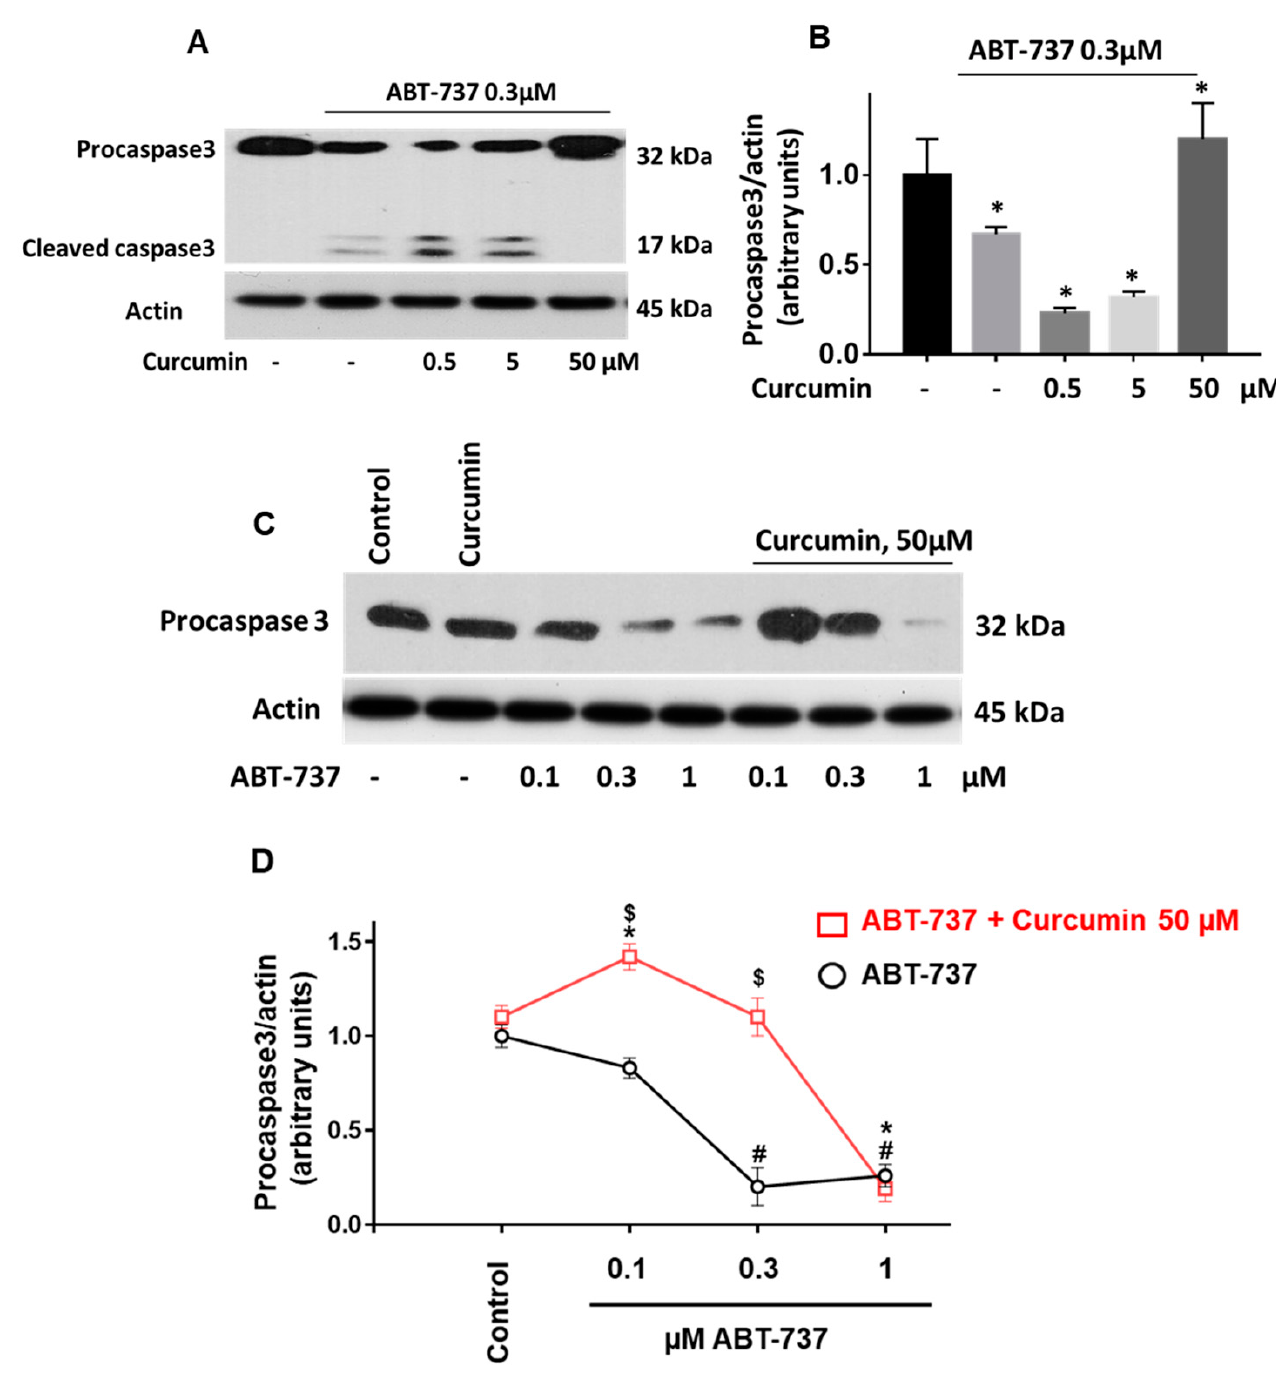
Figure 6. Curcumin at low concentrations stimulated and at high concentration inhibited platelet apoptosis induced by low concentrations of ABT-737. ( A , C ) Washed platelets (3 × 10 8 cells/mL) were incubated with the indicated concentrations of curcumin and ABT-737 for 60 min and analyzed by Western blotting for caspase 3 activation (procaspase 3, cleaved caspase 3). Actin blot served as a loading control. ( B , D ) Immunoblots were scanned and the intensity of bands was quantified by the ImageJ program. The intensity of the procaspase 3 signal was normalized to the actin signal. For each sample, this ratio is relatively expressed to the ratio for the control, which is presented as 1. Data are presented as means ± SD. For 6B: One-way ANOVA, Levene’s test p > 0.05 followed by Tukey’s HSD test * as appeared in the figure, p = 0.017; 0.001; 0.002; 0.005 compared to control, presented as 1. For 6D: One-way ANOVA, Levene’s test p > 0.05 followed by Tukey’s HSD test, compared to the corresponding controls, * as appeared in the figure p = 0.005; 0.002; # as appeared in the figure p = 0.001; 0.001; Paired t-test (“ABT-737 + Curcumin” vs. “ABT-737”) $ as appeared in the figure, p = 0.004; 0.002; n =